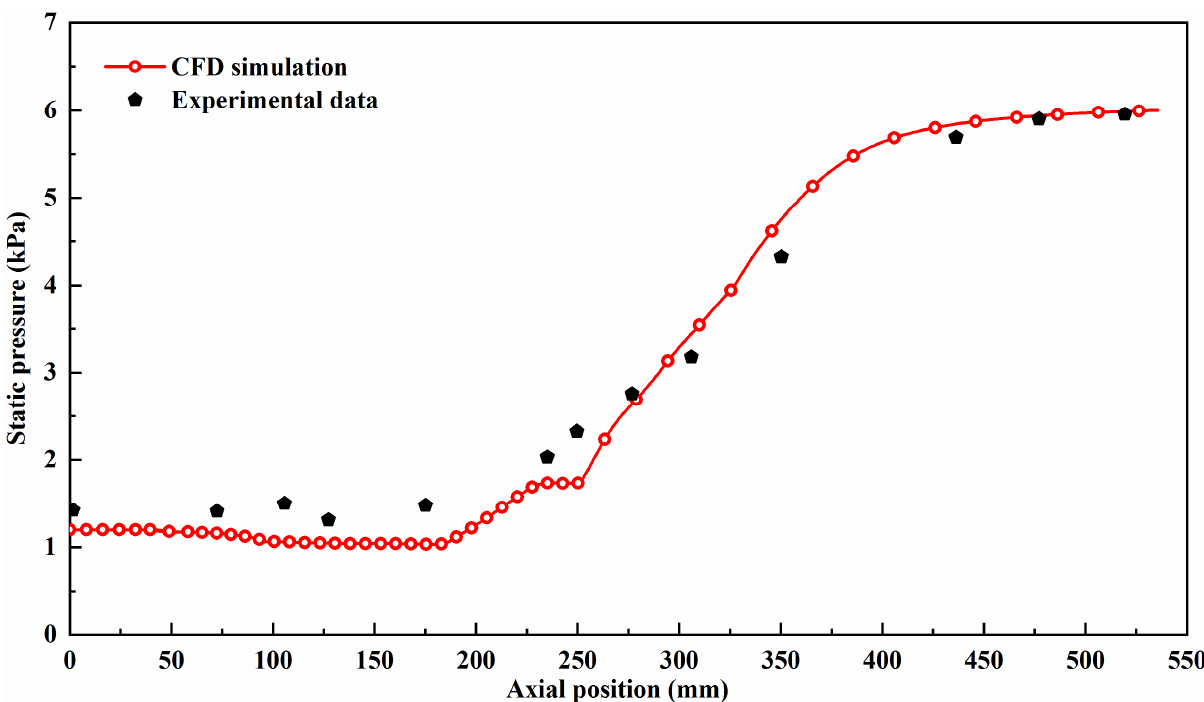
Figure 4. Comparison of numerical simulation and test results of near-wall pressure.